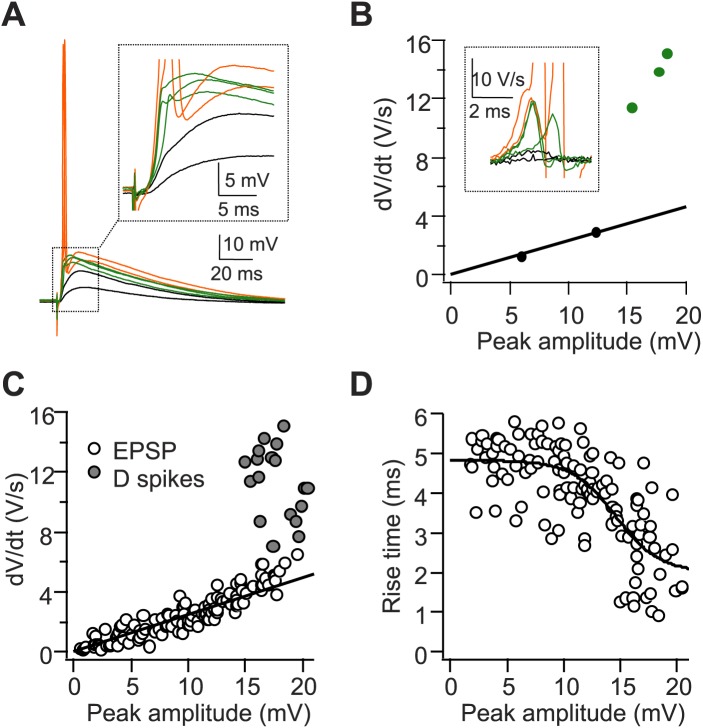
A single stimulus to the PP triggers dendritic spikes (D spikes) in CA2 PNs.(A) Sample traces of sub-threshold EPSPs (black), D spikes (green), and APs (orange) in a CA2 PN in response to PP stimuli of increasing strength. Inset: the expanded view from the dashed square. (B) dV/dt plotted against peak EPSP amplitude (APs are not shown). Traces and data points color-coded as in (A). Inset: dV/dt of corresponding traces from (A). APs are truncated. (C and D) Pooled data showing dV/dt (C) and the 20–80% EPSP rise time (D) plotted against peak EPSP amplitude (n = 9 cells).